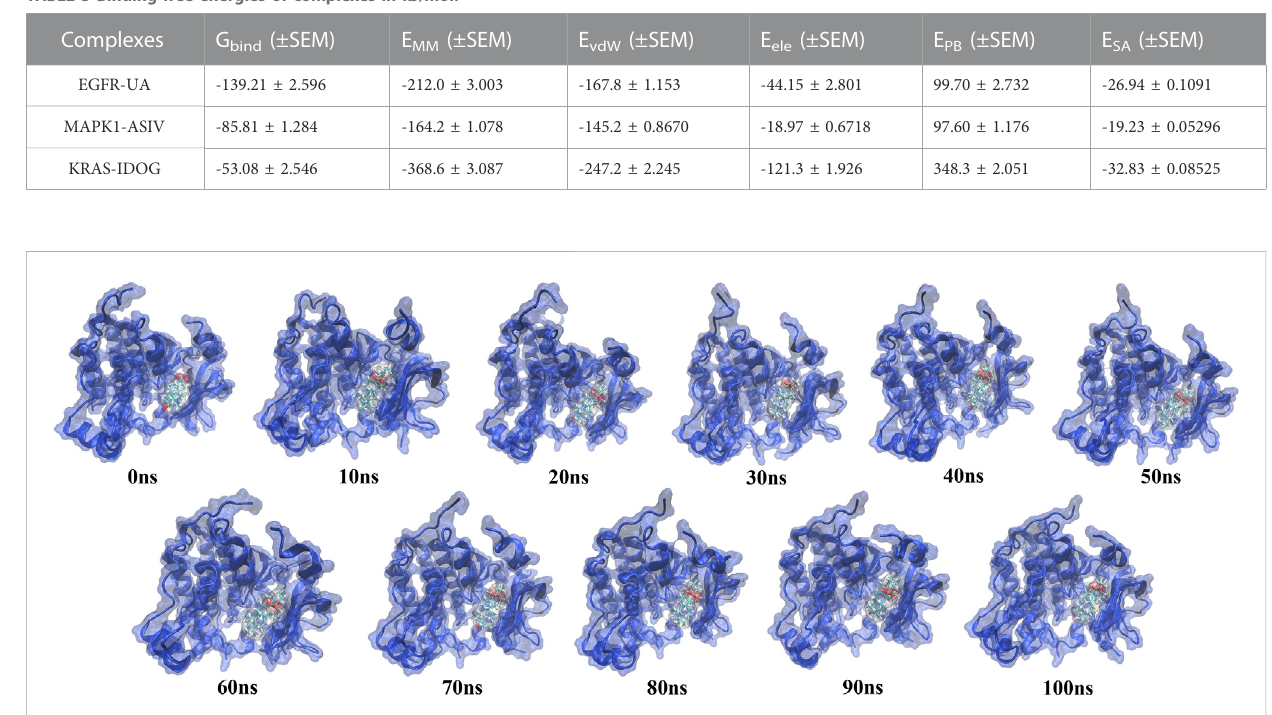
TABLE 3 Binding free energies of complexes in kJ/mol.